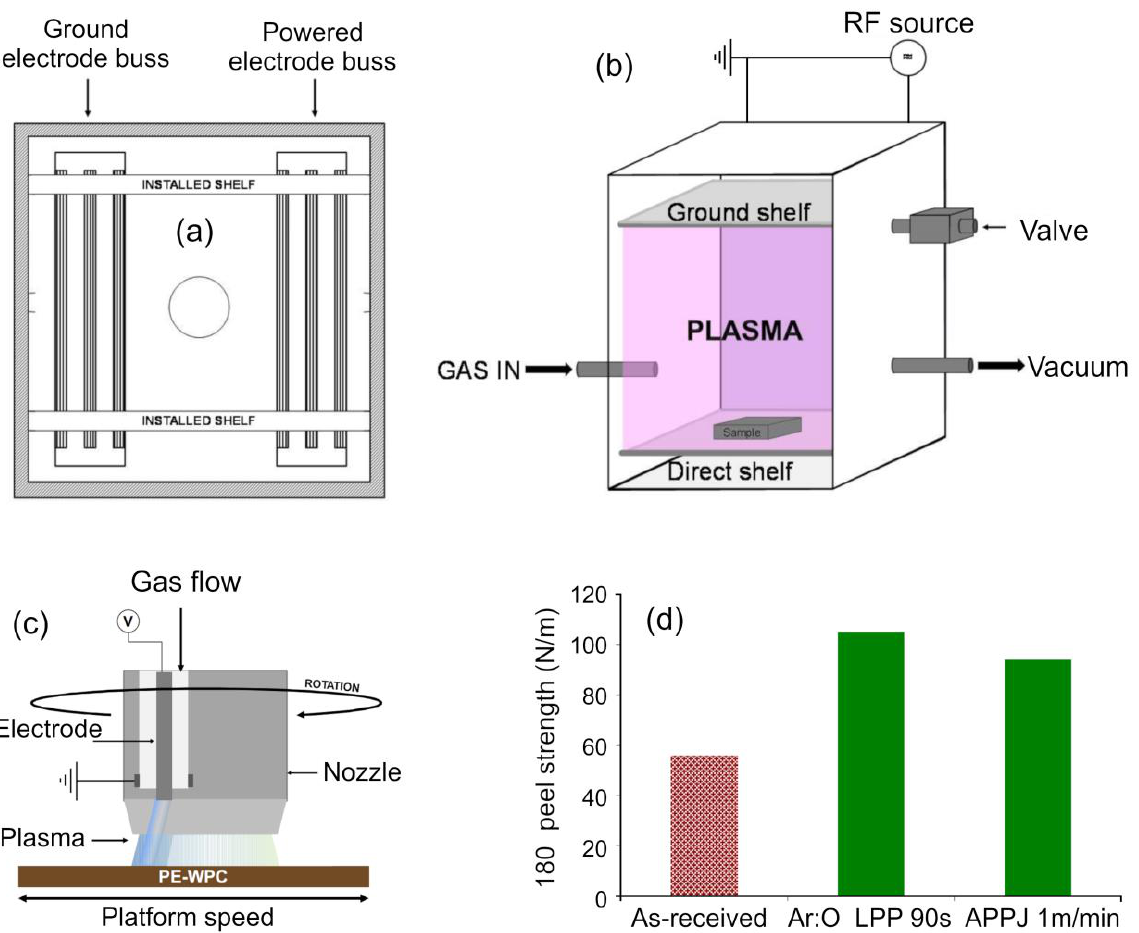
Figure 9. ( a , b ) Schematic of a low-pressure plasma (LPP) reactor used for the surface treatment of polyethylene wood plastic composite (PE-WPC) and chamber scheme and ( b ) the direct configuration scheme. ( c ) Schematic of an atmospheric pressure plasma jet (APPJ) system used for the surface treatment of PE-WPC. ( d ) The 180° peel strength values for an as-received and plasma-treated PE-WPC/acrylic adhesive joints. An adhesion failure always occurred. Reproduced from Yáñez-Pacios et al. (2018) [90] under conditions of the CC BY license.